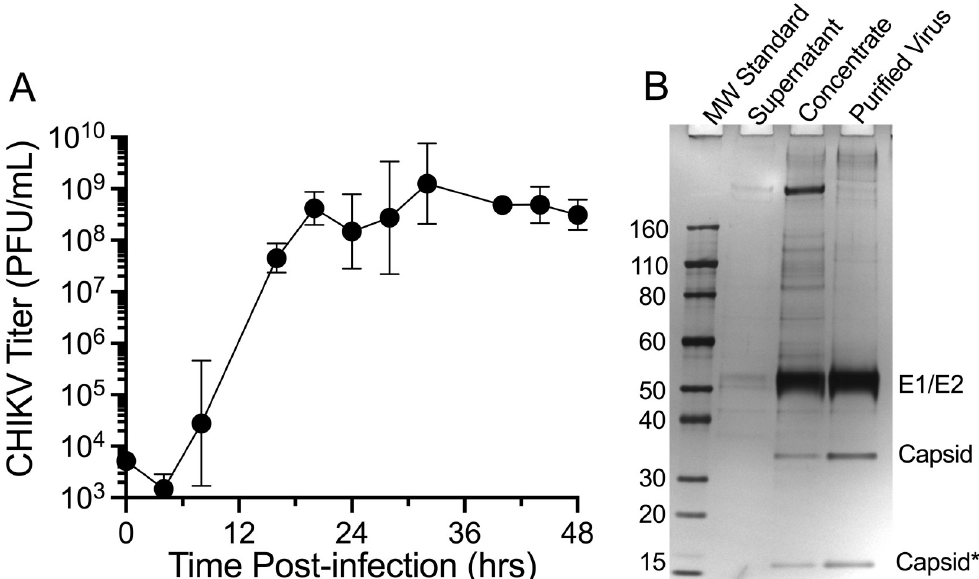
Fig 1. CHIKV growth kinetics and purification. (A) Growth kinetics for chikungunya virus strain 181/25 (CHIKV-181/ 25) were performed in triplicate in Vero cells under serum-free conditions at an MOI = 0.01. Geometric mean titers with 95% confidence intervals are shown. (B) CHIKV-181/25 supernatant was harvested at the peak of viral replication followed by concentration by tangential flow filtration (TFF) and purified virus was obtained after performing CaptoCore 700 (CC700) multimodal chromatography. Sample purity was assessed by SDS-PAGE followed by silver staining. Identity of the major protein bands in the CC700-processed sample was determined by mass spectrometry and include the co-migrating E1 and E2 envelope proteins (E1/E2), the full-length Capsid protein, as well as a band that corresponds to the Capsid C- terminal protease domain (Capsid � , [18]). The position of molecular weight markers (MW Standard) and the CHIKV structural proteins are